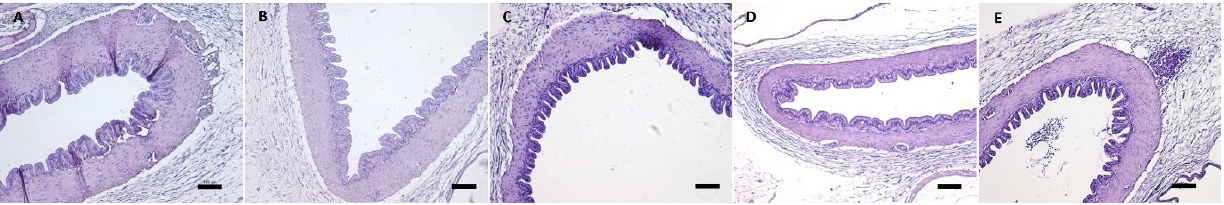
Figure 11. Swim bladder with normal aspect of salmon at different samplings times . ( A ) Control. ( B ) 1 week after exposure. ( C ) 2 weeks after exposure. ( D ) 3 weeks after exposure. ( E ) 4 weeks after exposure. Scale bar: 100 µm.